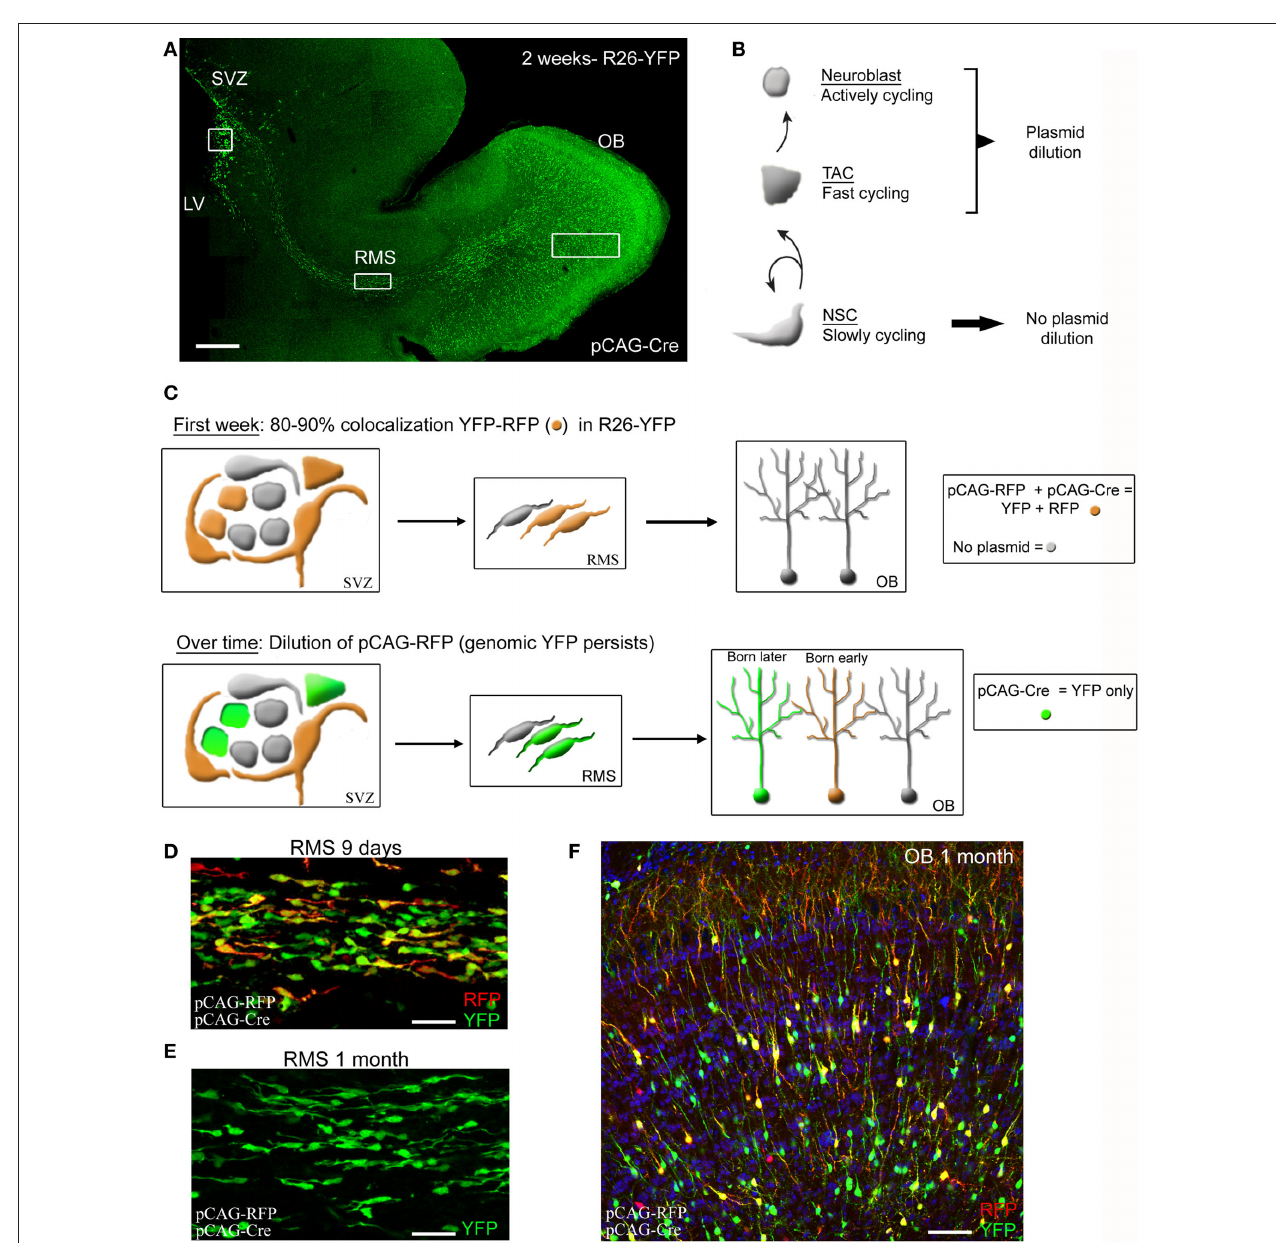
following pCAG-RFP dilution while astrocyte-like cells express RFP and YFP (orange). YFP is not diluted due to its genomic expression and as a result there will be an accumulation of YFP + neurons in the OB over time. (D–F) Confocal images of the RMS at 9 days and 1 month ( (D) and (e) , respectively), and olfactory bulb (OB) at 4 weeks post-electroporation (F) with pCAG-Cre and pCAG-RFP in a Rosa26-Stop-YFP mouse. Scale bars: 200 μm (A) , 50 μm (D) and (e)